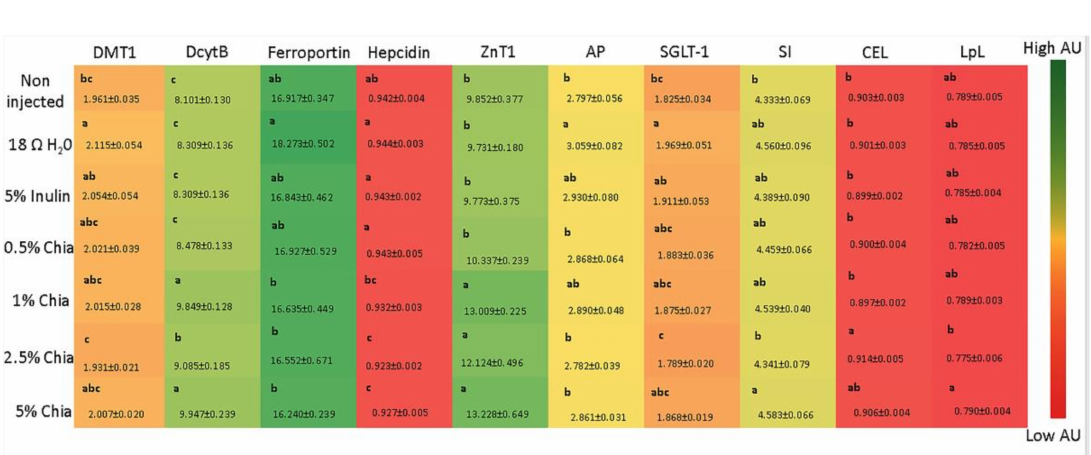
Figure 1. E ff ect of the intra-amniotic administration of experimental solutions on intestinal and liver gene expression. Values are the means ± SEM, n = 10. a–c Per gene, treatments groups not indicated by the same letter are significantly di ff erent ( p < 0.05). DMT1, Divalent metal transporter 1; Dcytb, Duodenal cytochrome b; ZnT1, Zinc transporter 1; AP, Amino peptidase; SGLT1, Sodium-Glucose transport protein 1; SI, Sucrose isomaltase; CEL, Carboxyl ester lipase; LpL, Lipoprotein